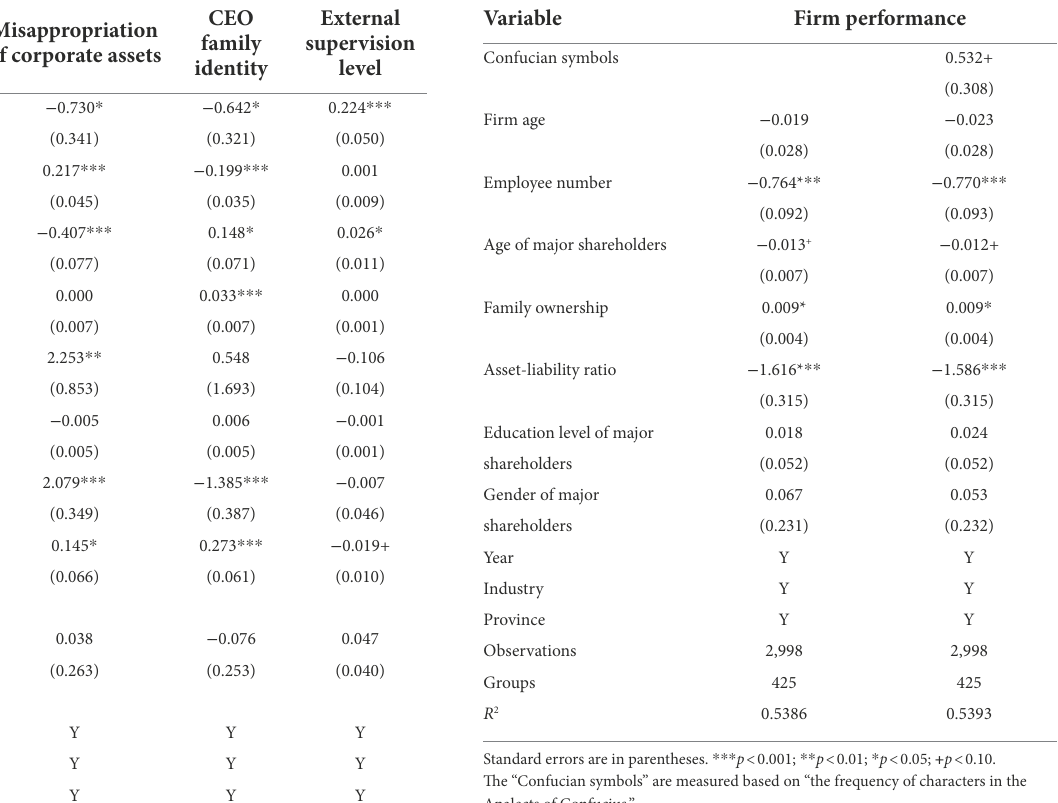
TABLE 9 Results of propensity score matching. TABLE 10 Effect of Confucian symbols on